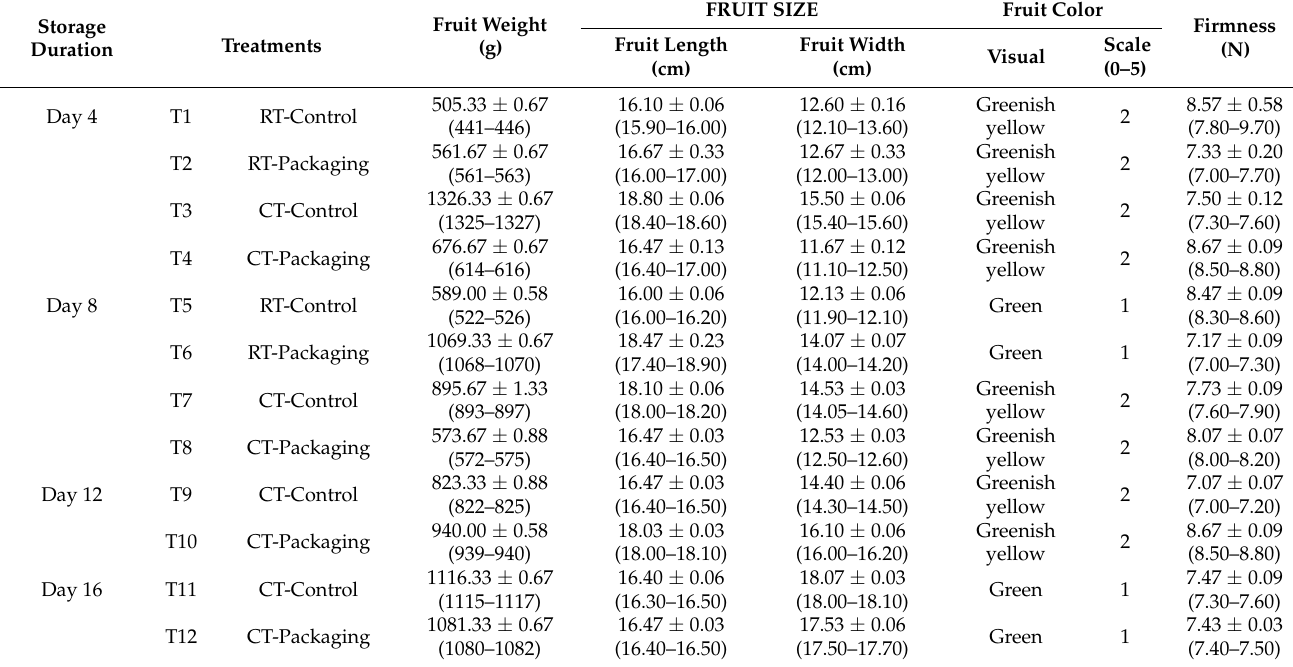
Table 1. Pre-fruit characterization of Artocarpus